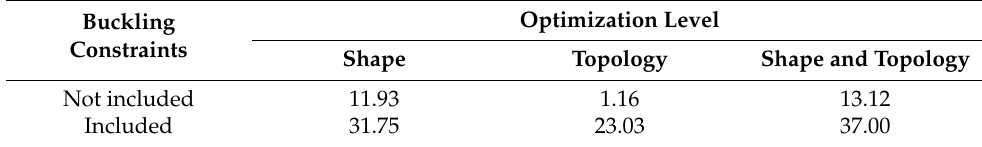
Table 8. Improvement in final result (in %) at different optimization